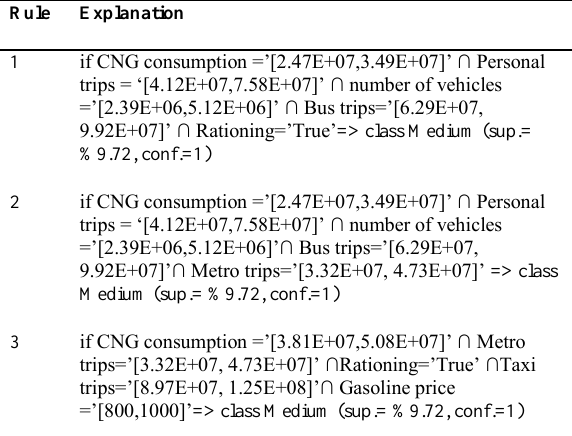
Table 6. Extracted rules for medium gasoline consumption by Apriori.